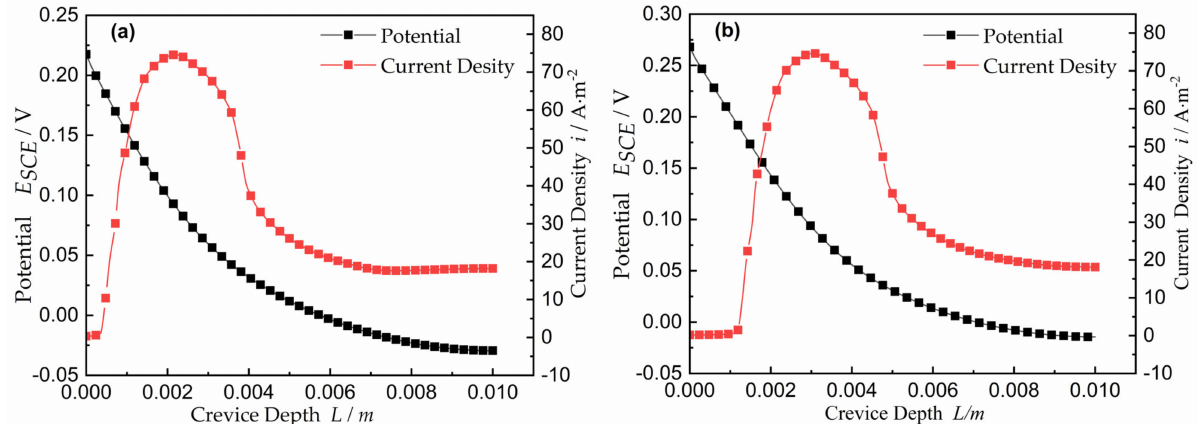
Figure 5. Potential E SCE and current density for time t = 0 and W = 0.3 mm: ( a ) the applied potential E A = 0.25 V; ( b ) the applied potential E A = 0.30